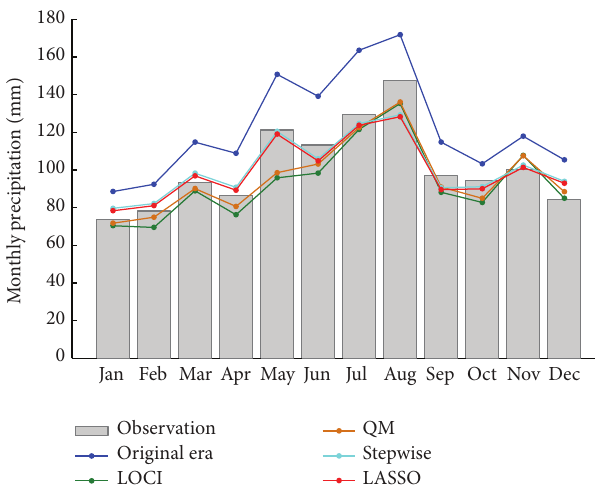
Figure 8: Comparison of averaged sum of daily precipitation for each month between observations and the four downscaled results, as well as the original ERA-Interim data in the validation period